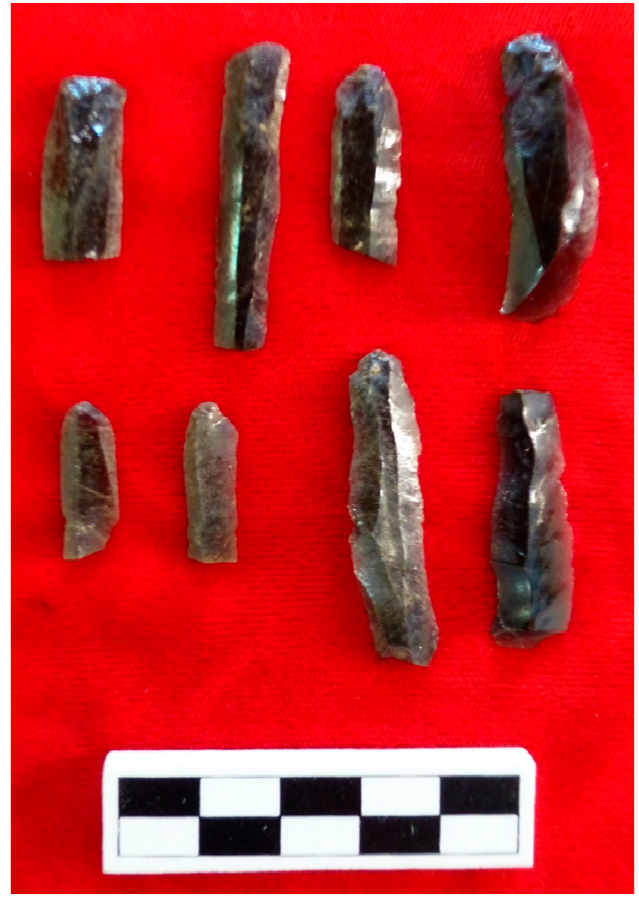
Figure 2. Example of Neolithic obsidian blade tools from Sicily. Scale in centimeters. Most stone tools would have been mounted on wood or bone handles (rarely preserved).